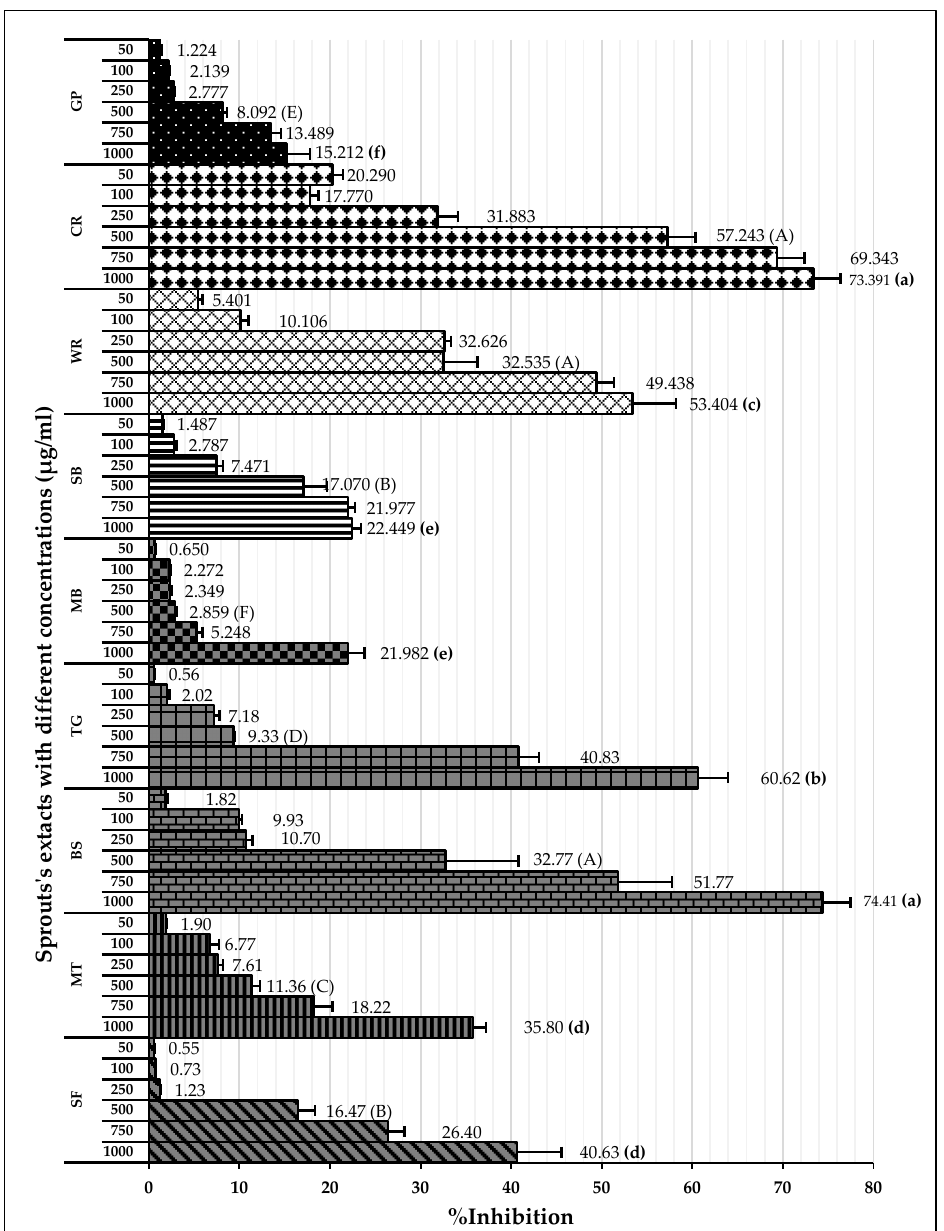
Figure 4. The percent of inhibition of ABTS radicals with different sprouts’ extract. Data are expressed Figure 4 . The percent of inhibition of ABTS radicals with di ff erent sprouts’ extract. Data are ex- as mean ± SD from five replicates. Different letters (a–f) and (A–F) indicate a significant difference pressed as mean ± SD from fi ve replicates. Di ff erent le tt ers (a–f) and (A–F) indicate a signi fi cant between samples at the same concentration ( p < di ff erence between samples at the same concentration ( p < 0.05).